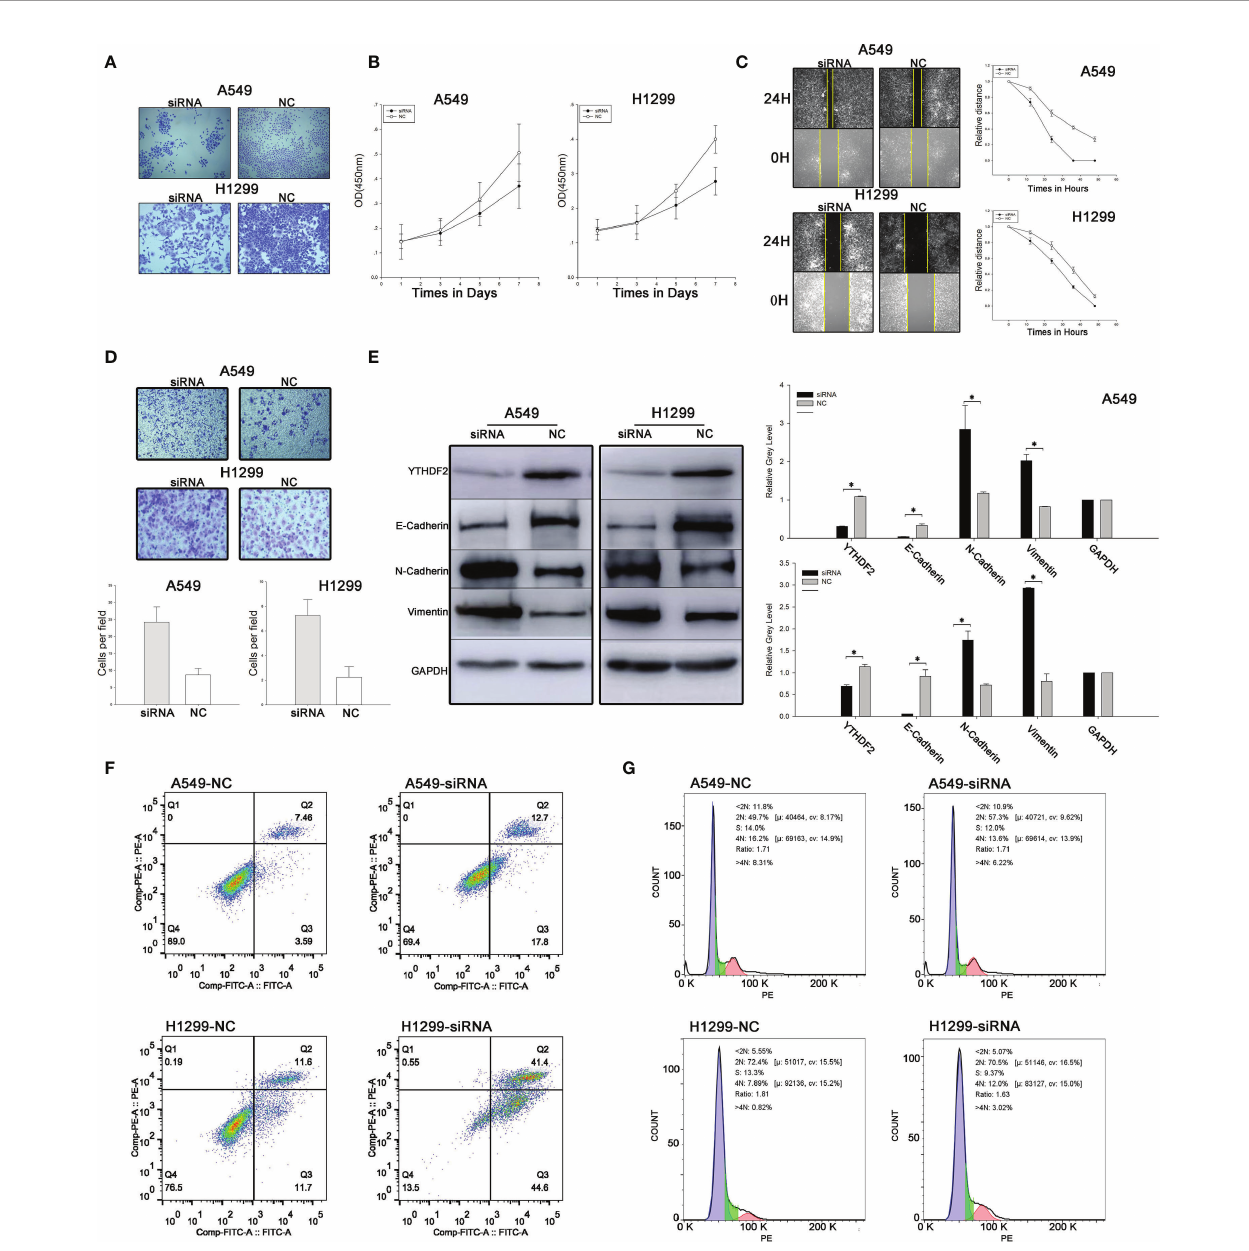
FIGURE 2 | YTHDF2 knockdown leads to increased migration and invasion and decreased proliferation of lung adenocarcinoma cell lines. (A) Colony formation assay using normal and YTHDF2 knockdown cell lines. (B) MTT assay using normal and YTHDF2 knockdown cell lines. (C) Wound healing assay using normal and YTHDF2 knockdown cell lines. (D) Transwell assay of normal and YTHDF2 knockdown cell lines. (E) EMT-related protein expression in normal and YTHDF2 knockdown cell lines was analysed using WB and the relative greyscale values of 3 repetitions are shown. (F) Apoptosis status in normal and YTHDF2 knockdown cell lines was analysed using fl ow cytometry. (G) Cell cycle status in normal and YTHDF2 knockdown cell lines was analysed using fl ow cytometry. *Statistical difference (P <